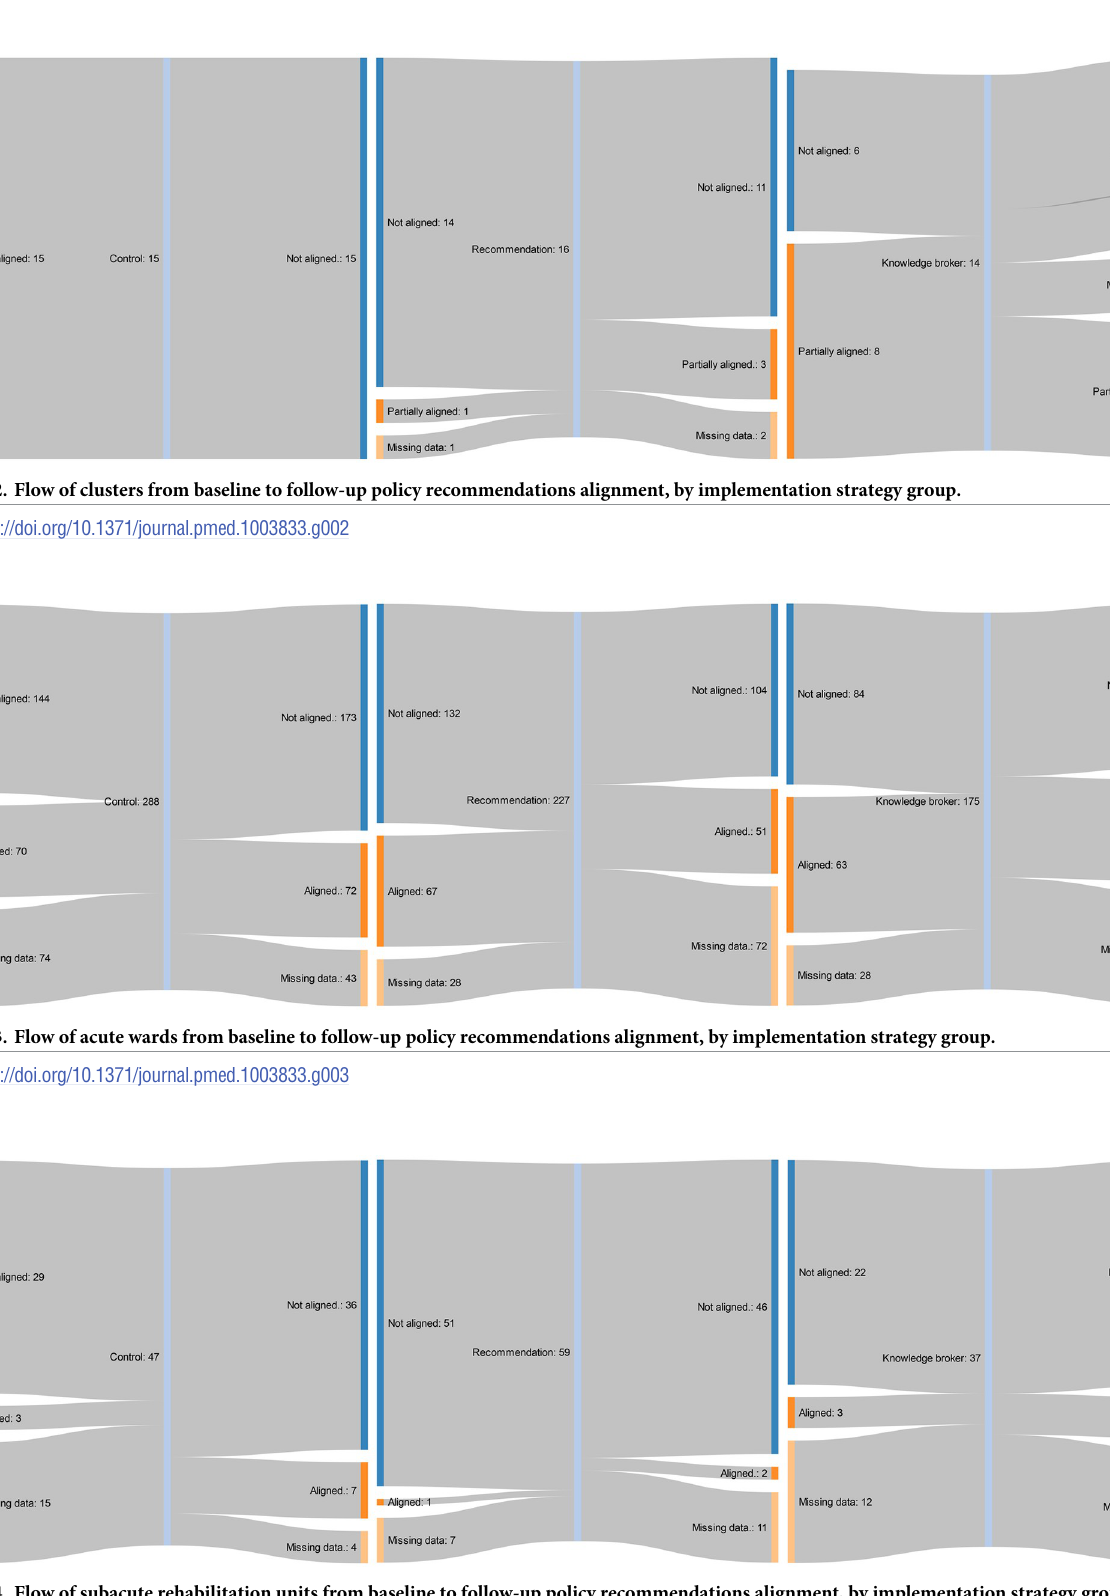
PLOS Medicine| https://doi.org/10.1371/journal.pmed.1003833 October 22, 2021 14 /